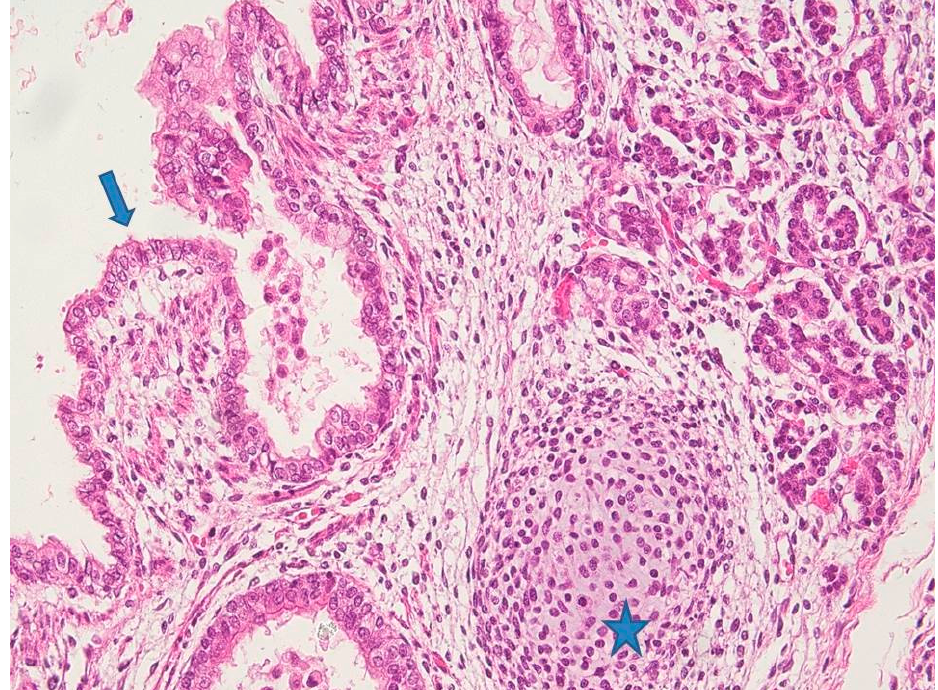
Figure 4. Histology of mature components of the neoplasia: endodermal elements with respiratory cilitaed epithelium (blue arrow) and glands (top right of the picture). Cartilage (mesoderm) was also present (star). (Hematoxylin Eosin (HE) staining 10×).